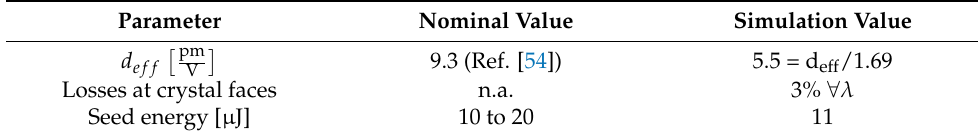
Table 5. Applied simulation values to best fit the experimental results.